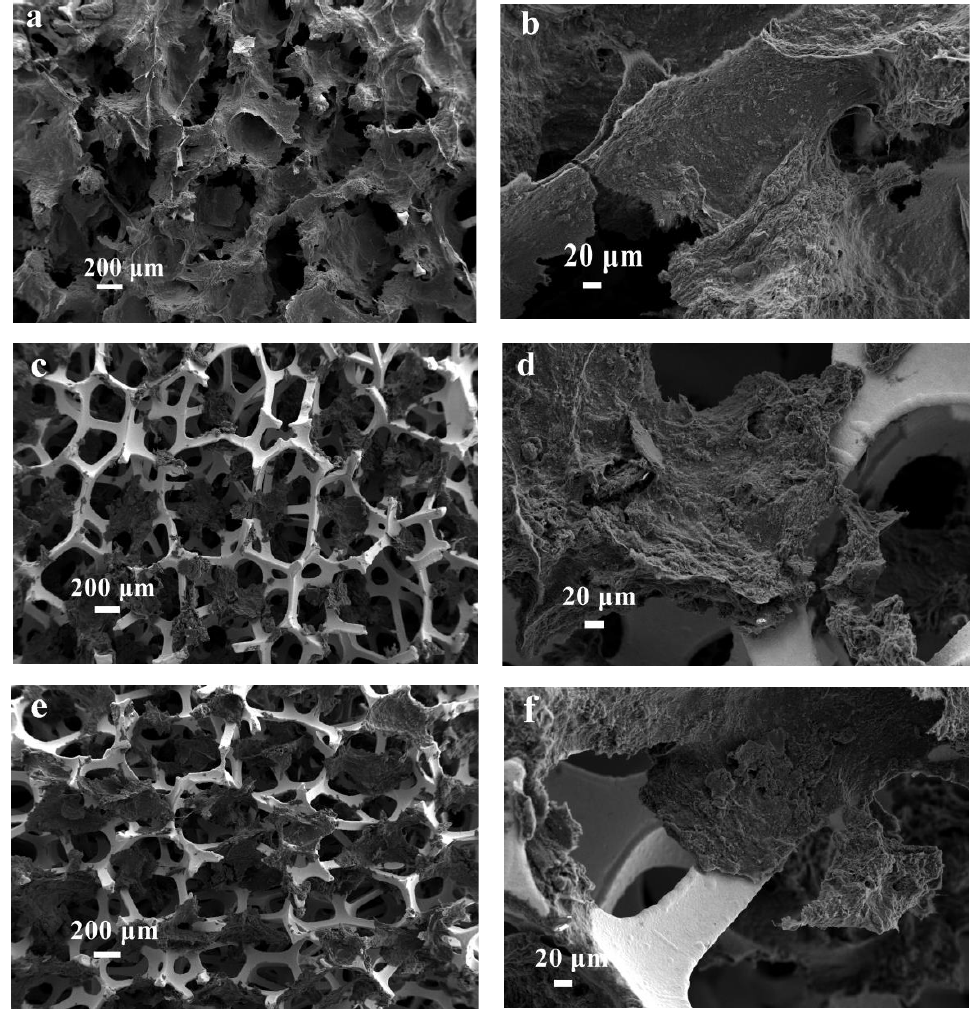
Figure 4. SEM images of ( a , b ) B1, ( c , d ) D1, ( e , f ) E1 electrodes at different magnifications.